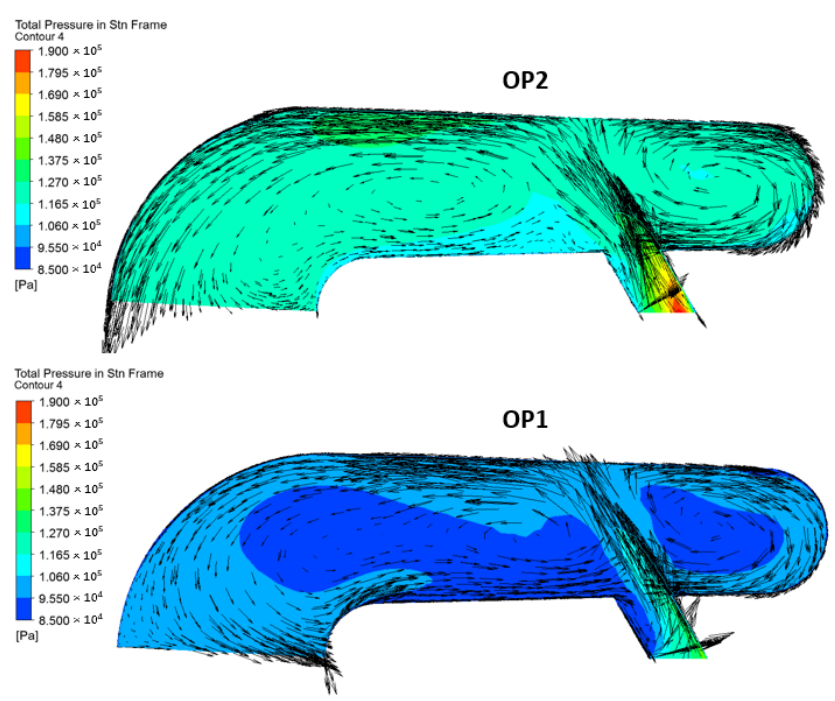
Figure 11. Contours of total pressure with superimposed the velocity vectors inside the cavity at the near surge condition OP2 ( upper ) and best efficiency OP1 ( lower ). Table 3. Main flow characteristics exiting from section A of the cavity at the conditions OP1 (best efficiency) and OP2 (near surge).